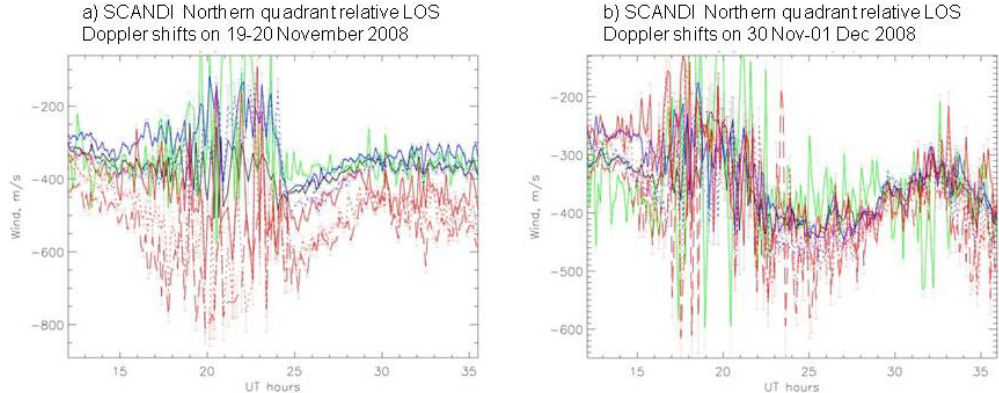
Fig. 11. The effect of fine-tuning the parallelism of the etalon is to make the baselines of all the rings similar. (a) SCANDI LOS winds (without baseline correction) seen in the quadrant to the North on the night of the 19 November 2008 before the etalon parallelism was fine-tuned. There is a large systematic difference between rings. (b) SCANDI LOS winds (without baseline correction) seen to the North on the night of the 30 November 2008 after the etalon parallelism was fine-tuned. The systematic difference between rings is small. Zone 1 (inner circle) = green; zones 2–5 (ring 1) = black; zones 6–13 (ring 2) = blue; zones 14–25 (ring 3) =